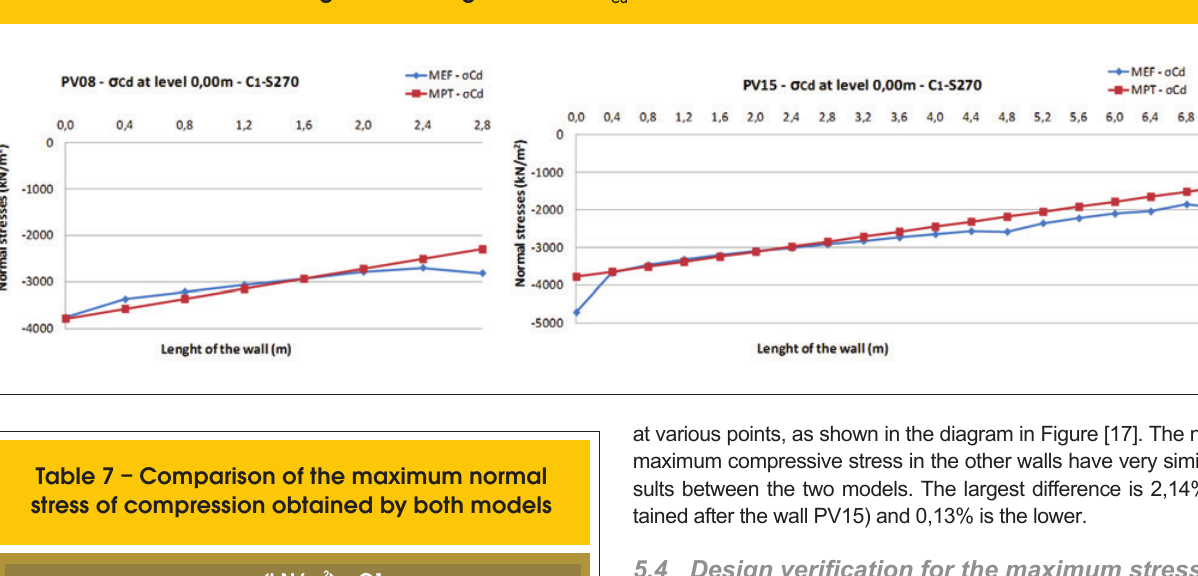
Figure 17 – Diagram of the s of the walls PV08 and PV15 Cd